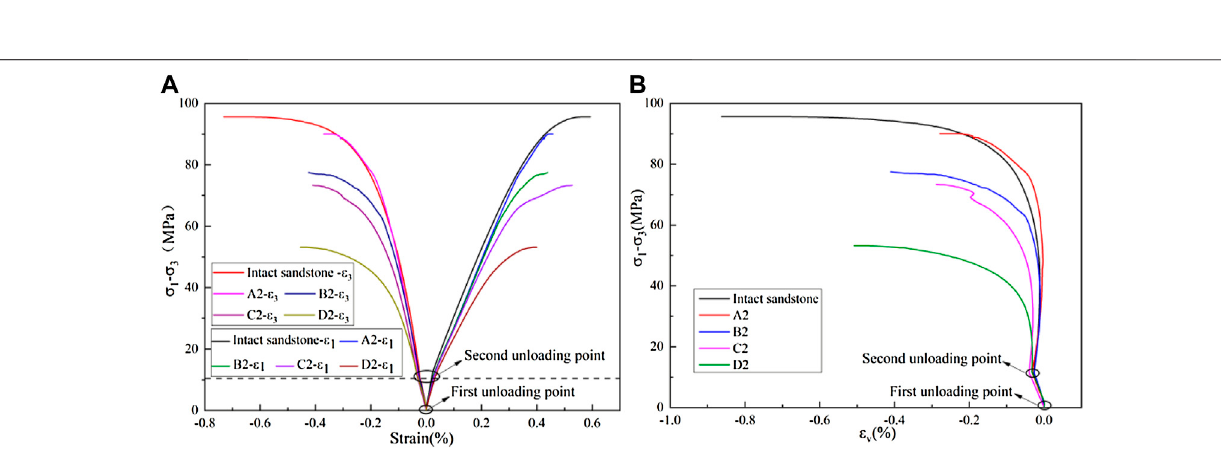
Frontiers in Earth Science |